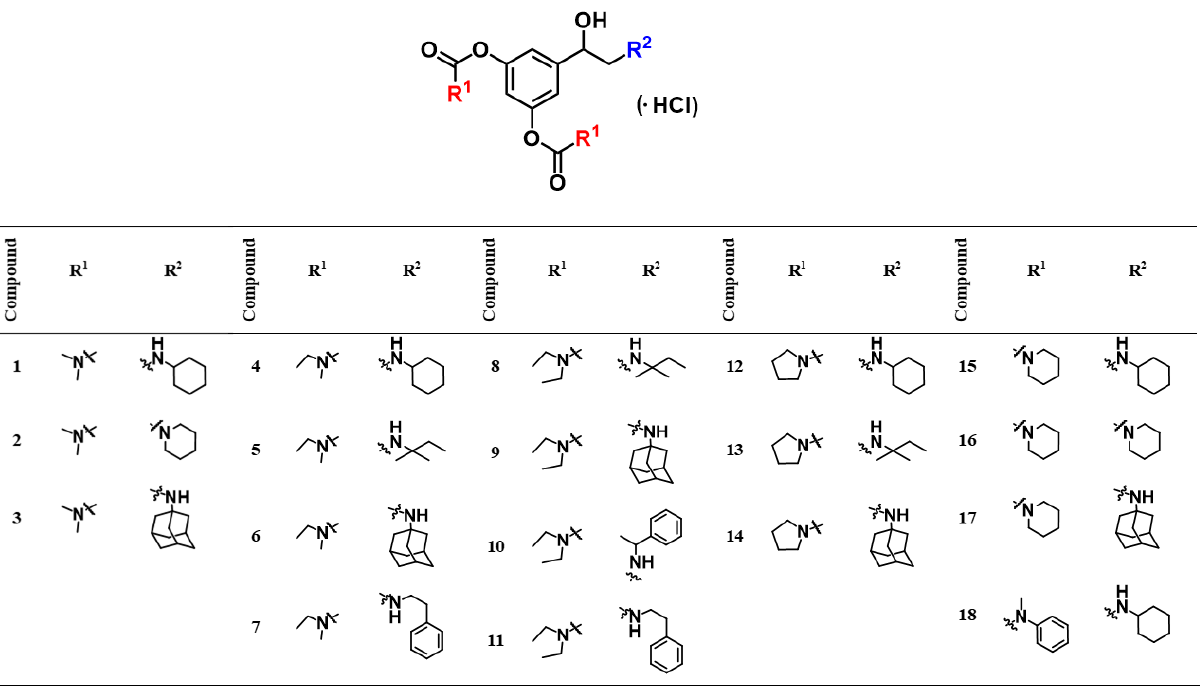
Figure 2. General structure of the synthesized biscarbamates .